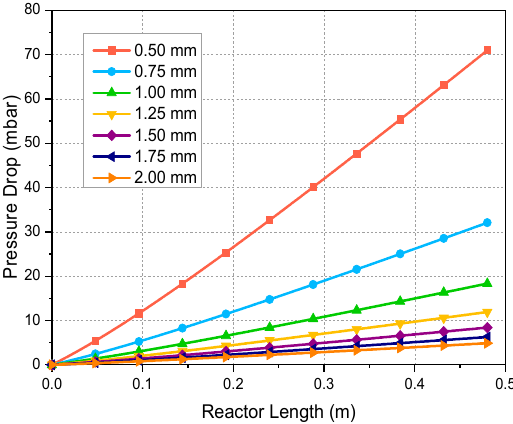
Figure 5. Pressure drop along the length of reactor with different particle sizes.